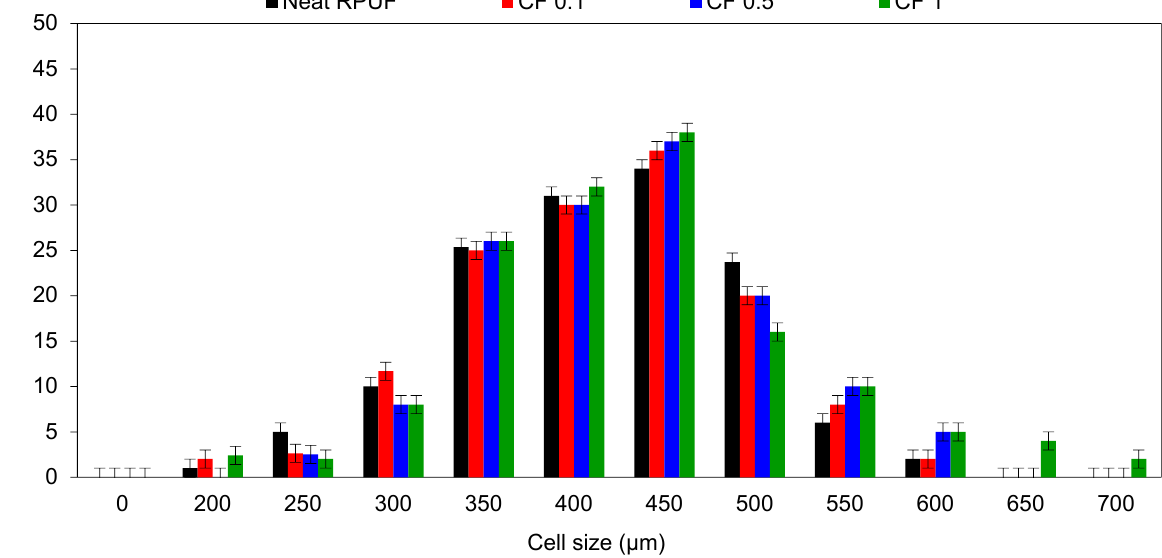
Figure 3. Cell size distribution for the studied RPUF composites.